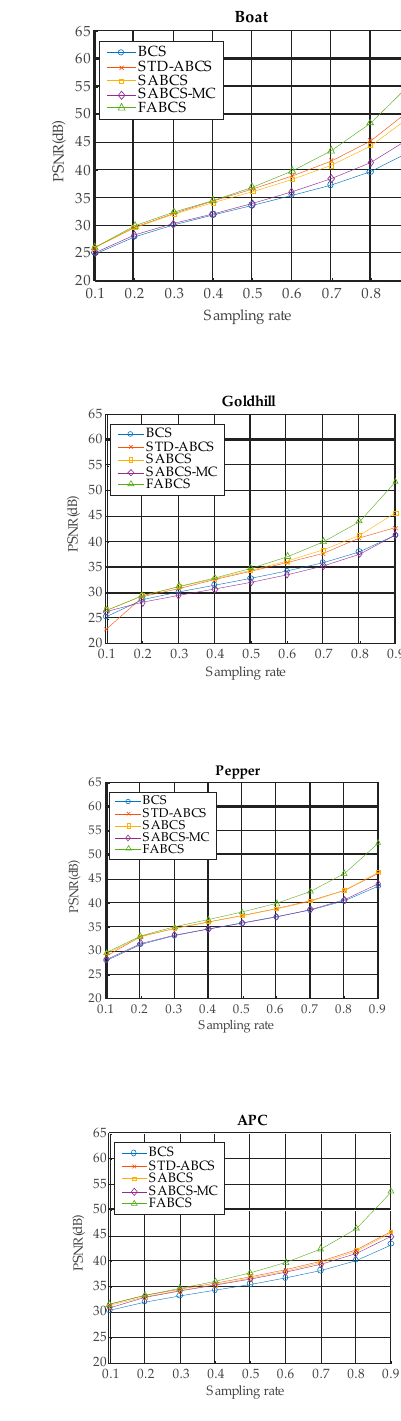
Figure 11. The experimental results for a block size of 16 ×